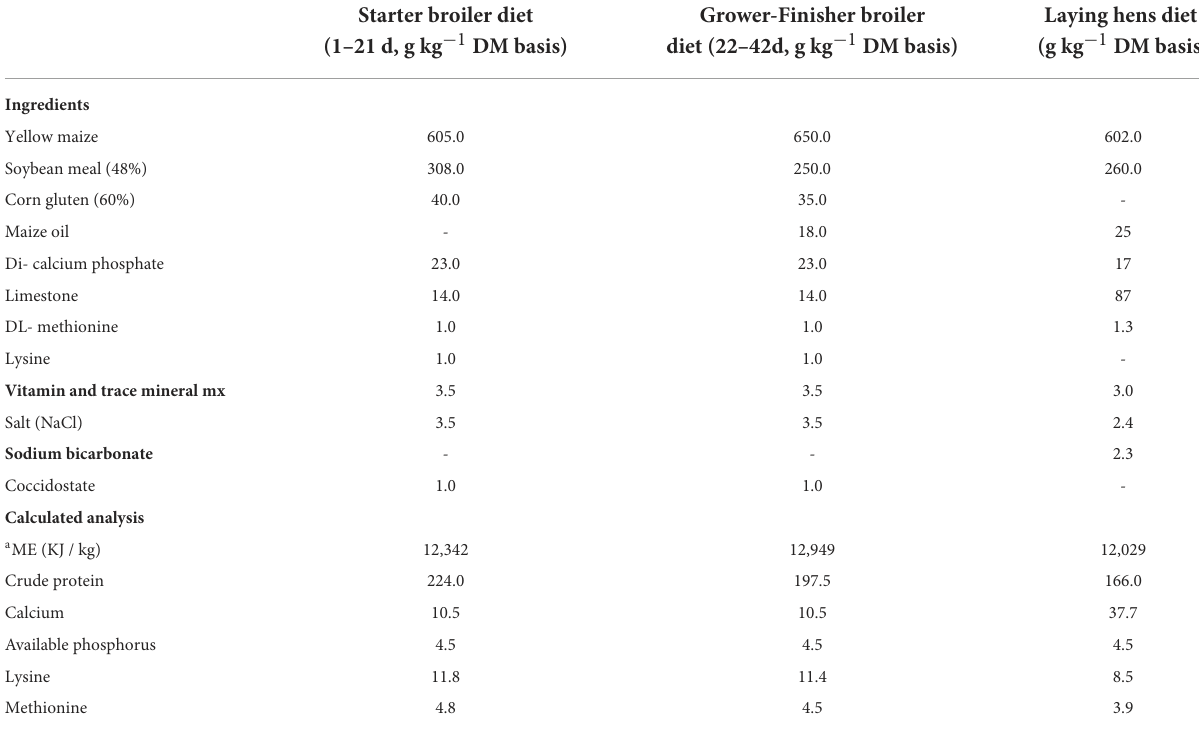
TABLE 1 Ingredient composition and calculated chemical analysis of the basal diets for broiler and laying hens. Starter broiler